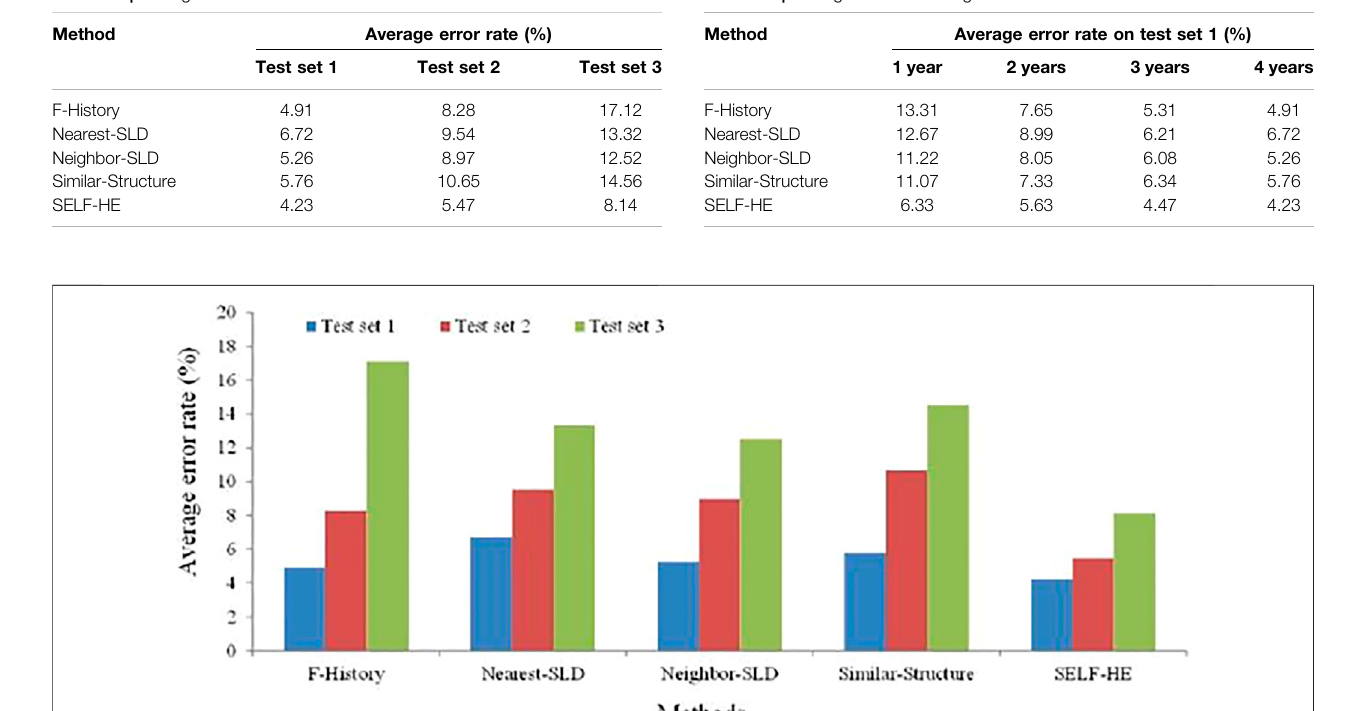
TABLE 1 | Average error rates of the fi ve methods.